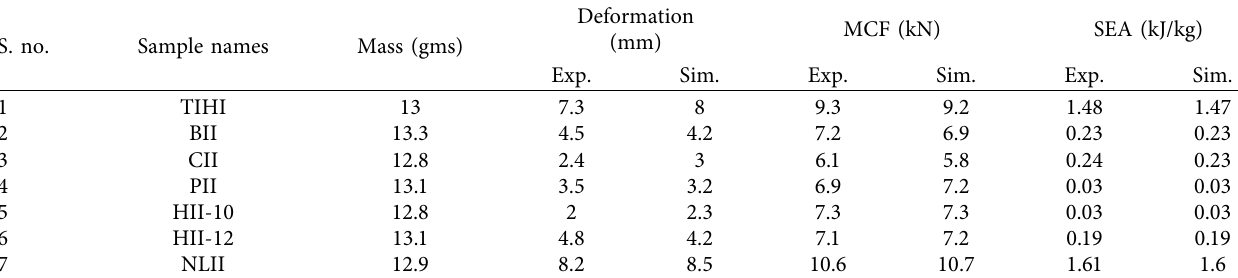
Table 2: Te crushing parameters for nature-inspired